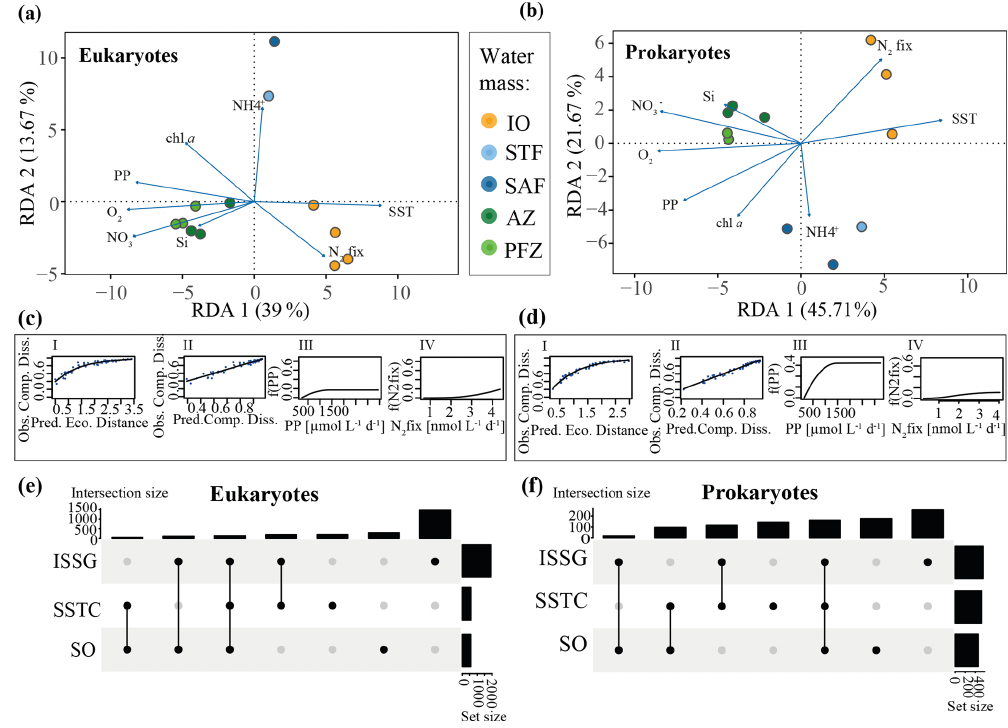
Figure 4. (a) Eukaryotic and (b) prokaryotic community structures of different water masses measured during the MD206 cruise. Redun- dancy analysis (RDA) of 18S and 16S rRNA gene ASV tables as response variables and environmental metadata as explanatory variables; environmental metadata are represented as arrows. Constrained analyses were performed by water mass. There were significant relation- ships between water masses and community dissimilarities (PERMANOVA, 999 permutations; p < 0 . 001, R 2 = 0 . 67 for eukaryotes and p < 0 . 001, R 2 = 0 . 74 for prokaryotes). Colors indicate major water masses according to the legend: yellow bar highlights the Indian South Subtropical Gyre (ISSG), light blue bar highlights the Subtropical Front (STF), blue bar highlights the Subantarctic Front (SAF), dark green bar highlights the Polar Front Zone (PFZ), and light green bar highlights the Antarctic Zone (AZ). Eukaryotic (c) and prokaryotic (d) general dissimilarity model (GDM) with (I) observed compositional dissimilarity against predicted ecological distance, calculated from temperature + dissolved oxygen + NO − + NH + + Si + chl a + PP + N 2 fixation; (II) observed compositional dissimilarity against predicted composi- 3 4 tional dissimilarity to test the model fit; and contribution of (III) PP and (IV) N 2 fixation to community dissimilarity expressed as a function of the environmental parameter ( f ( PP ) and f ( N 2 fix ) , respectively). For all functional plots of environmental data of the GDM analysis, see Fig. S11. Eukaryotic (e) and prokaryotic (f) UpSet plots of ASV intersections between Longhurst provinces. Analyses are based on binary tables (presence or absence) and the sum of all ASVs found across samples within one province. Intersection size shows number of ASVs shared between provinces (black dots, associated) and ASVs only found in one province (only black dot). Set size shows number of ASVs found in a specific Longhurst